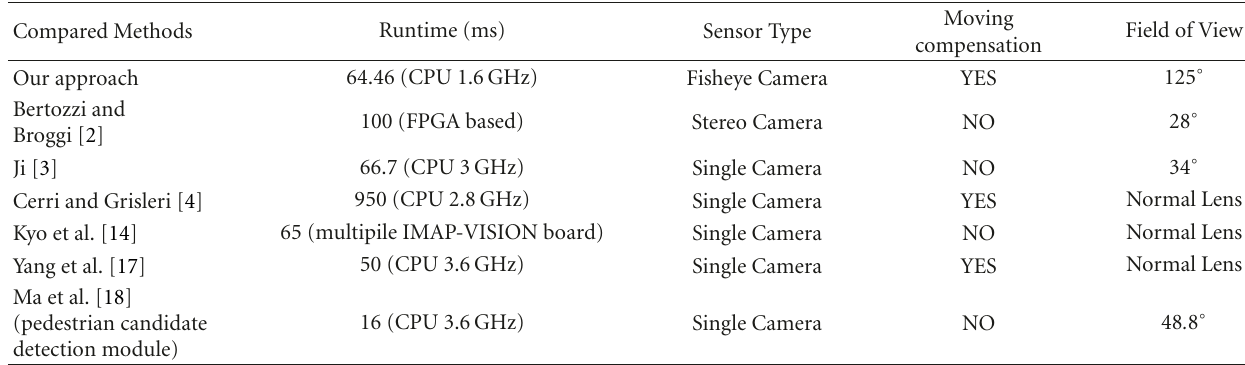
Table 3: Comparisons of di ff erent obstacle